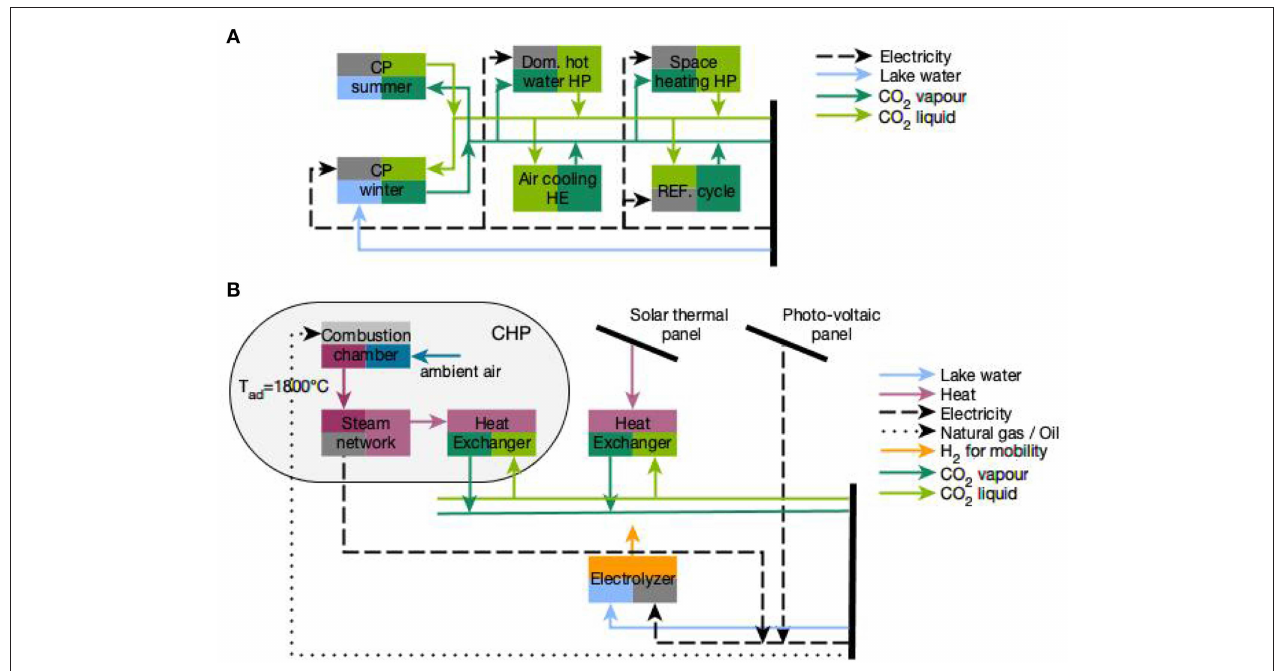
FIGURE 7 | Schematic description scenario 3 (A) and scenario 4 (B)